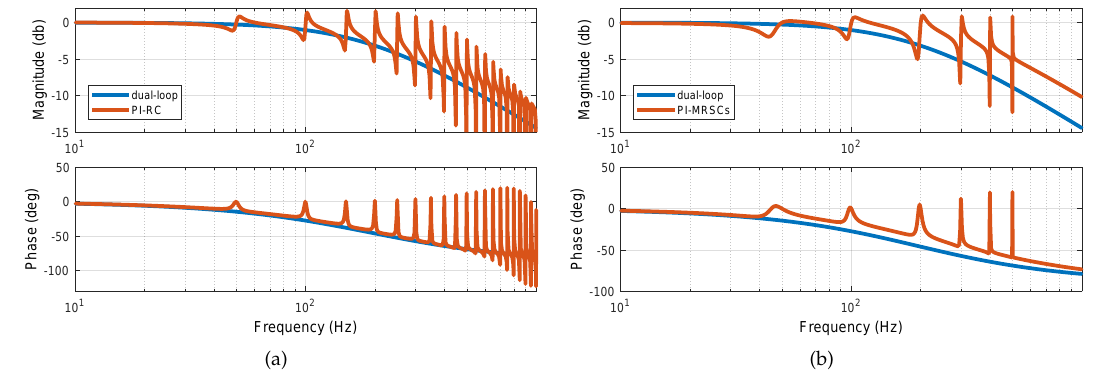
Figure 9. Frequency response of the reference tracking performance. ( a ) The proposed dual-loop controller and the controller containing the plug-in RC; ( b ) The proposed dual-loop controller and the controller containing MRSCs.